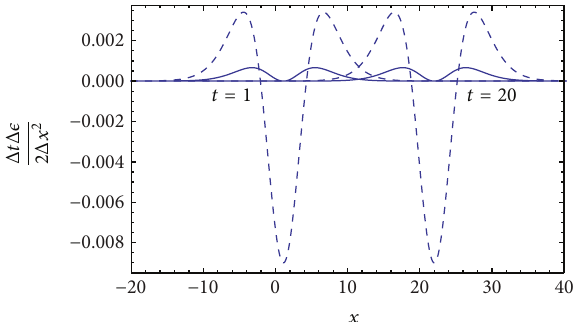
Figure 2: Plot comparing the behaviour of the modified equations obtained for the nonstandard approximation (21) (− − −) and the nonstandardapproximation(24)(solidline)tothenonlineartermin the RLW equation after substituting the single solitary wave solution totheRLWequation(8)with(23)and(27)taking V = 0.1 and 𝑥 0 = 0